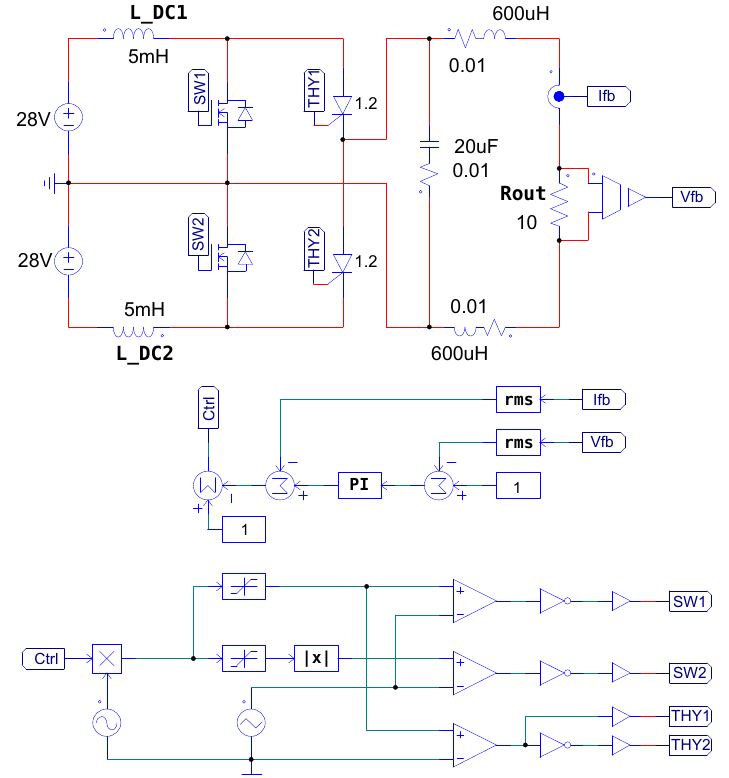
Figure 7. Proposed half-bridge CSI circuit simulation, showing current–source, waveshaper switches, half-bridge inverter and closed-loop control